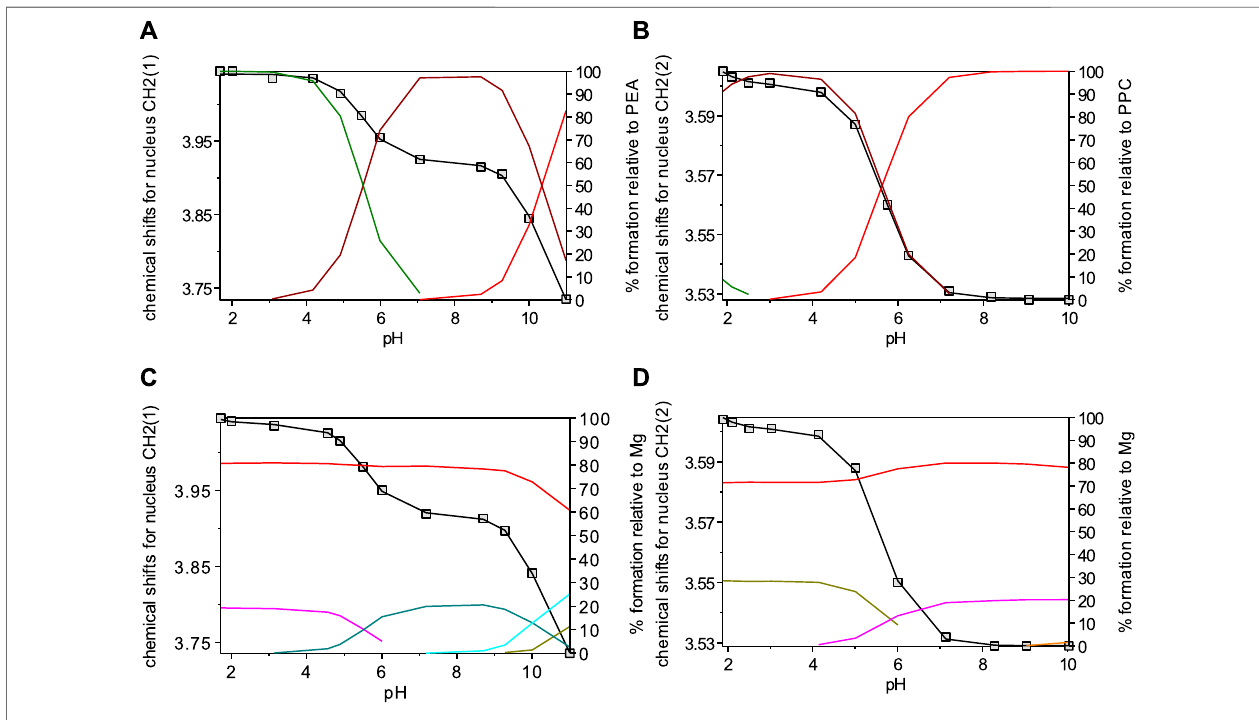
FIGURE 4 | Overlap of calculated (line) and observed ( □ ) chemical shifts with speciation diagrams obtained by HypNMR on solutions at t = 25 ° C and I = 0.15 mol L − 1 containing: (A) PEAatC PEA =7.6 mmol L − 1 (Lines:green,LH 2 ;brown,LH;red,L); (B) PPCatC PPC =7 mmol L − 1 (Lines:green,LH 2 ;brown,LH;red,L);